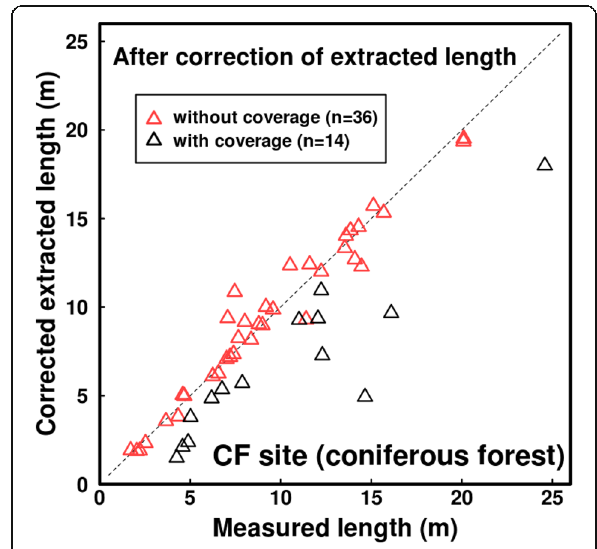
Fig. 6 Comparison between corrected extracted length and measured length of the wood pieces at the coniferous forest (CF) site. The corrected extracted length indicates that the inclined length was corrected from the extracted length (i.e., orthogonally projected length) using the directly measured inclination of the wood pieces